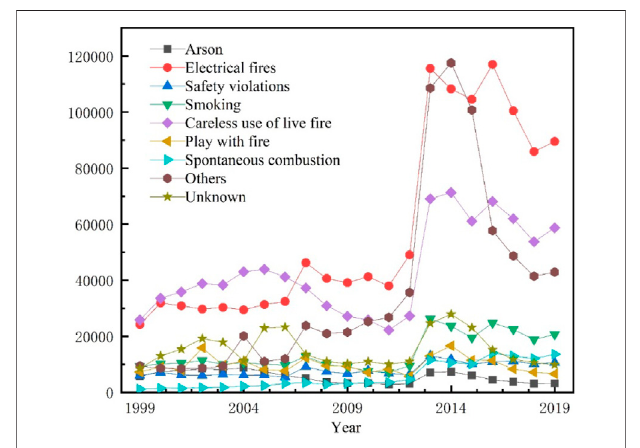
FIGURE 7 | The causes of the fi